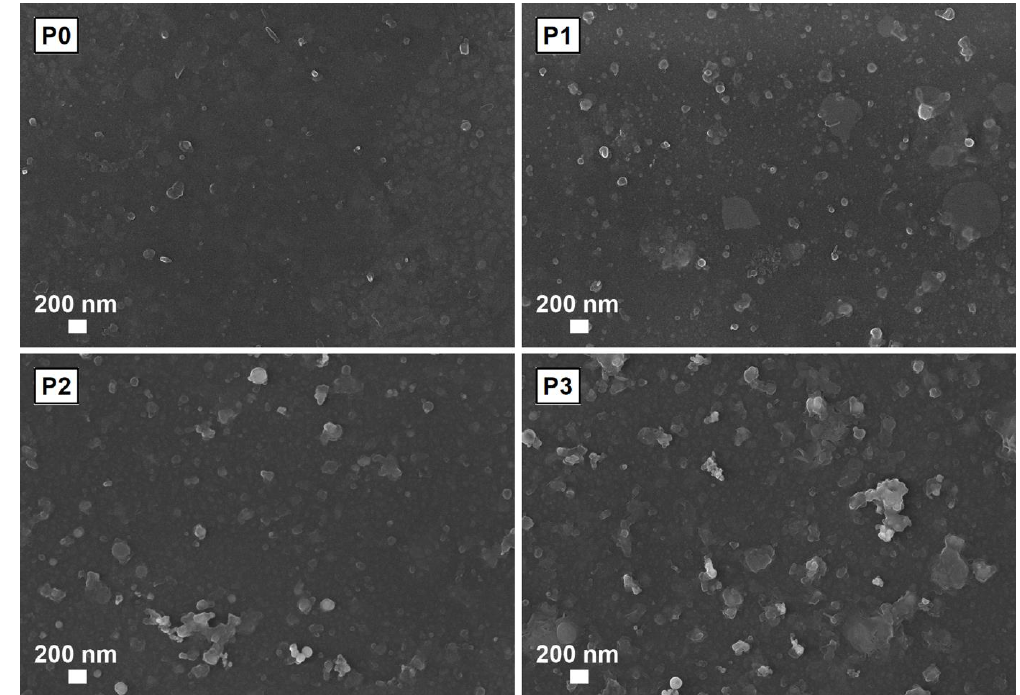
Figure 5. FESEM images at higher magnification of the MAPLE-deposited thin films. Nanomaterials 2020 , 10 , x FOR PEER REVIEW